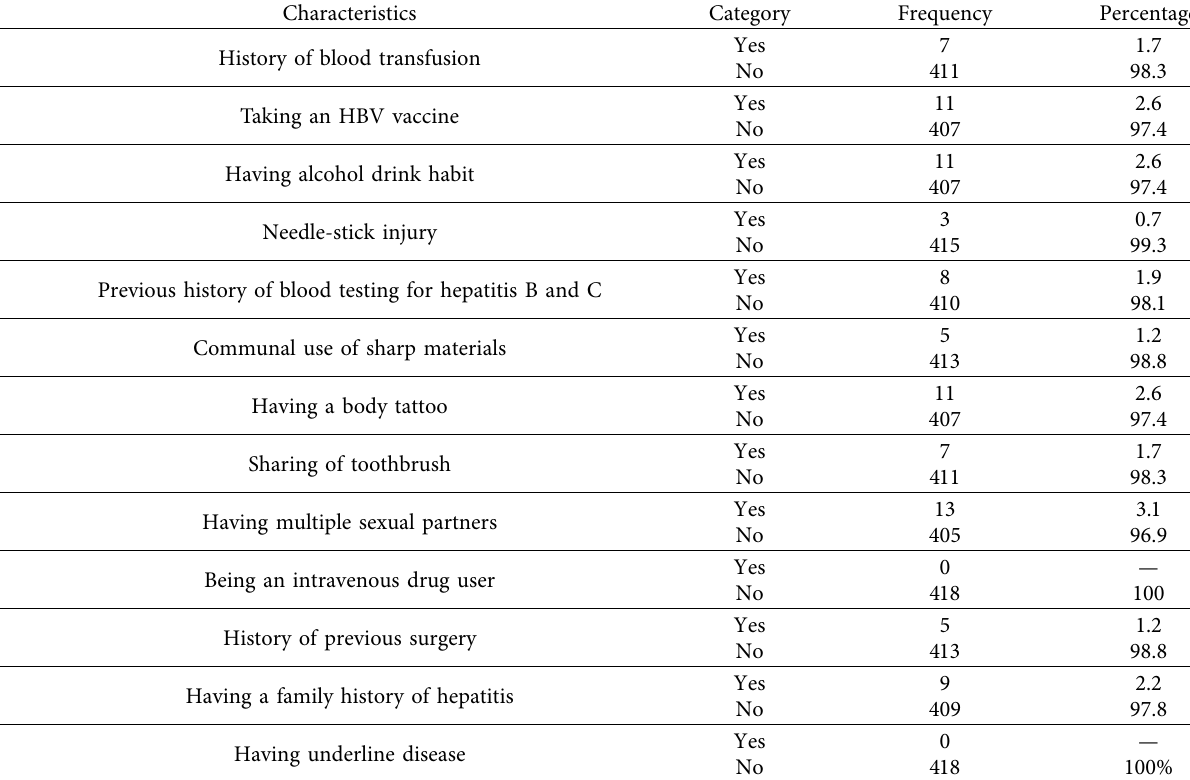
Table 2: Determinant factors for HBV and HCV infection among blood donors at Bahir Dar Blood Bank, Northwest Ethiopia, 2020 ( n � 418).